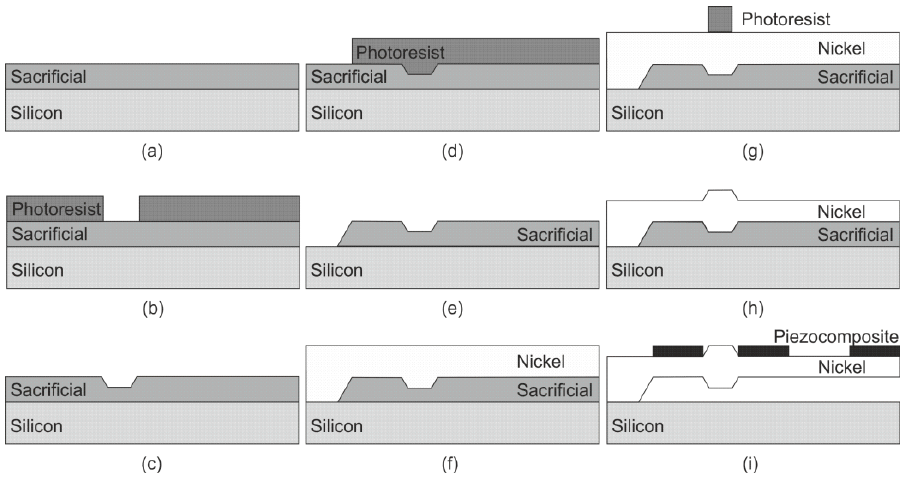
Figure 14. Microfabrication of microcantilever OPT RAT: ( a ) deposition of sacrificial layer; ( b ) deposition and patterning of photoresist; ( c ) patterning of sacrificial layer and removal